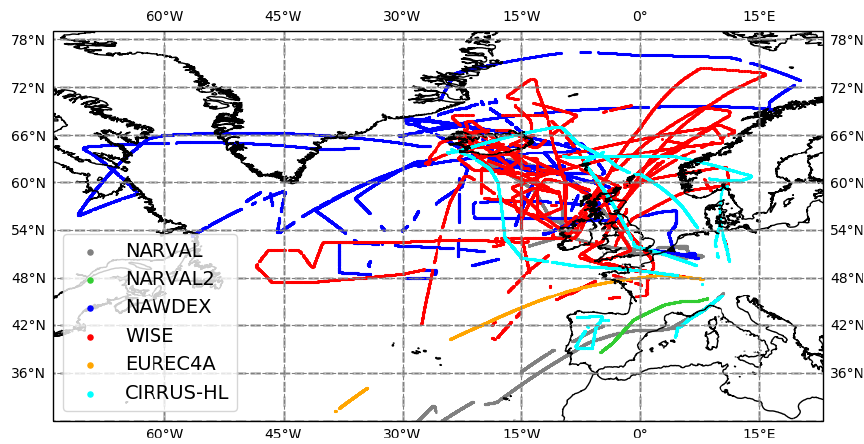
Figure 1. Map of HALO flight sections with WALES DIAL water vapour observations during the research campaigns NARVAL, NARVAL2, NAWDEX, WISE, EUREC 4 A, and CIRRUS-HL (for a detailed overview, see Sect. 2.1). Table 1. Overview of all considered campaigns with DIAL observations. The number of DIAL profiles refers to all profiles that were sampled during 41 flights. The number of DIAL profiles in the LS corresponds to all profiles with measurements in the LS. Campaign Month and year Season No. of flights Flight distance No. of DIAL No. of DIAL (hours) (km) profiles profiles in the LS NARVAL Dec–Jan 2013/2014 Winter 7 (41) 31157 10973 5288 NARVAL2 Aug 2016 Summer 1 (9) 7729 2395 485 NAWDEX Sep–Oct 2016 Autumn 11 (75) 55695 19139 12062 WISE Sep–Oct 2017 Autumn 14 (105) 83041 13557 9493 EUREC 4 A Jan–Feb 2020 Winter 1 (8) 7011 2307 1009 CIRRUS-HL Jun–Jul 2021 Summer 7 (30) 23675 6777 4568 Total 41 (268) 208308 55148